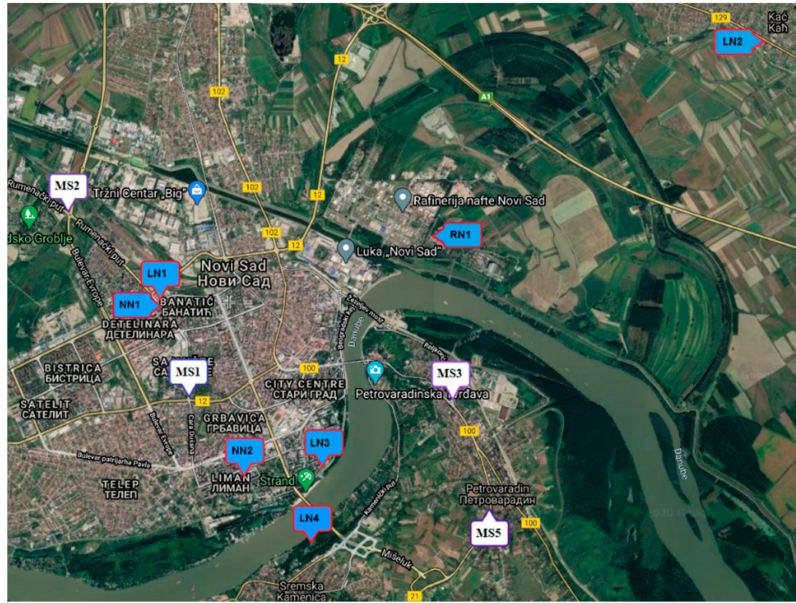
Figure 1. Map with location of measuring sites (MS1, MS2, MS3, MS5) and monitoring stations at national (NN), regional (RN) and local level